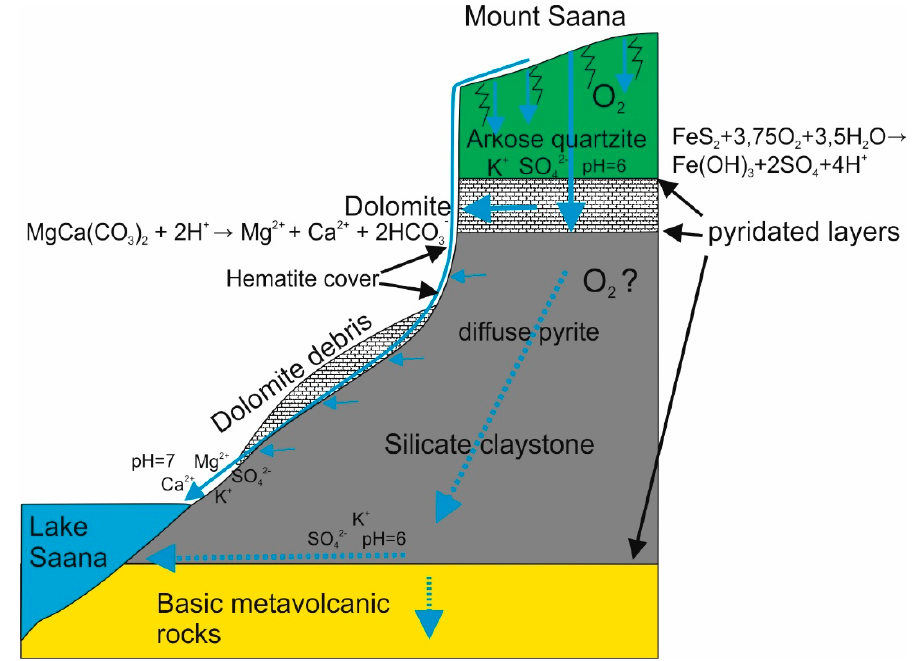
Figure 12. A conceptual model of the geochemical situation on the eastern slope of Mount Saana with the main directions of water flow paths. The totted arrows indicate possible water flow.